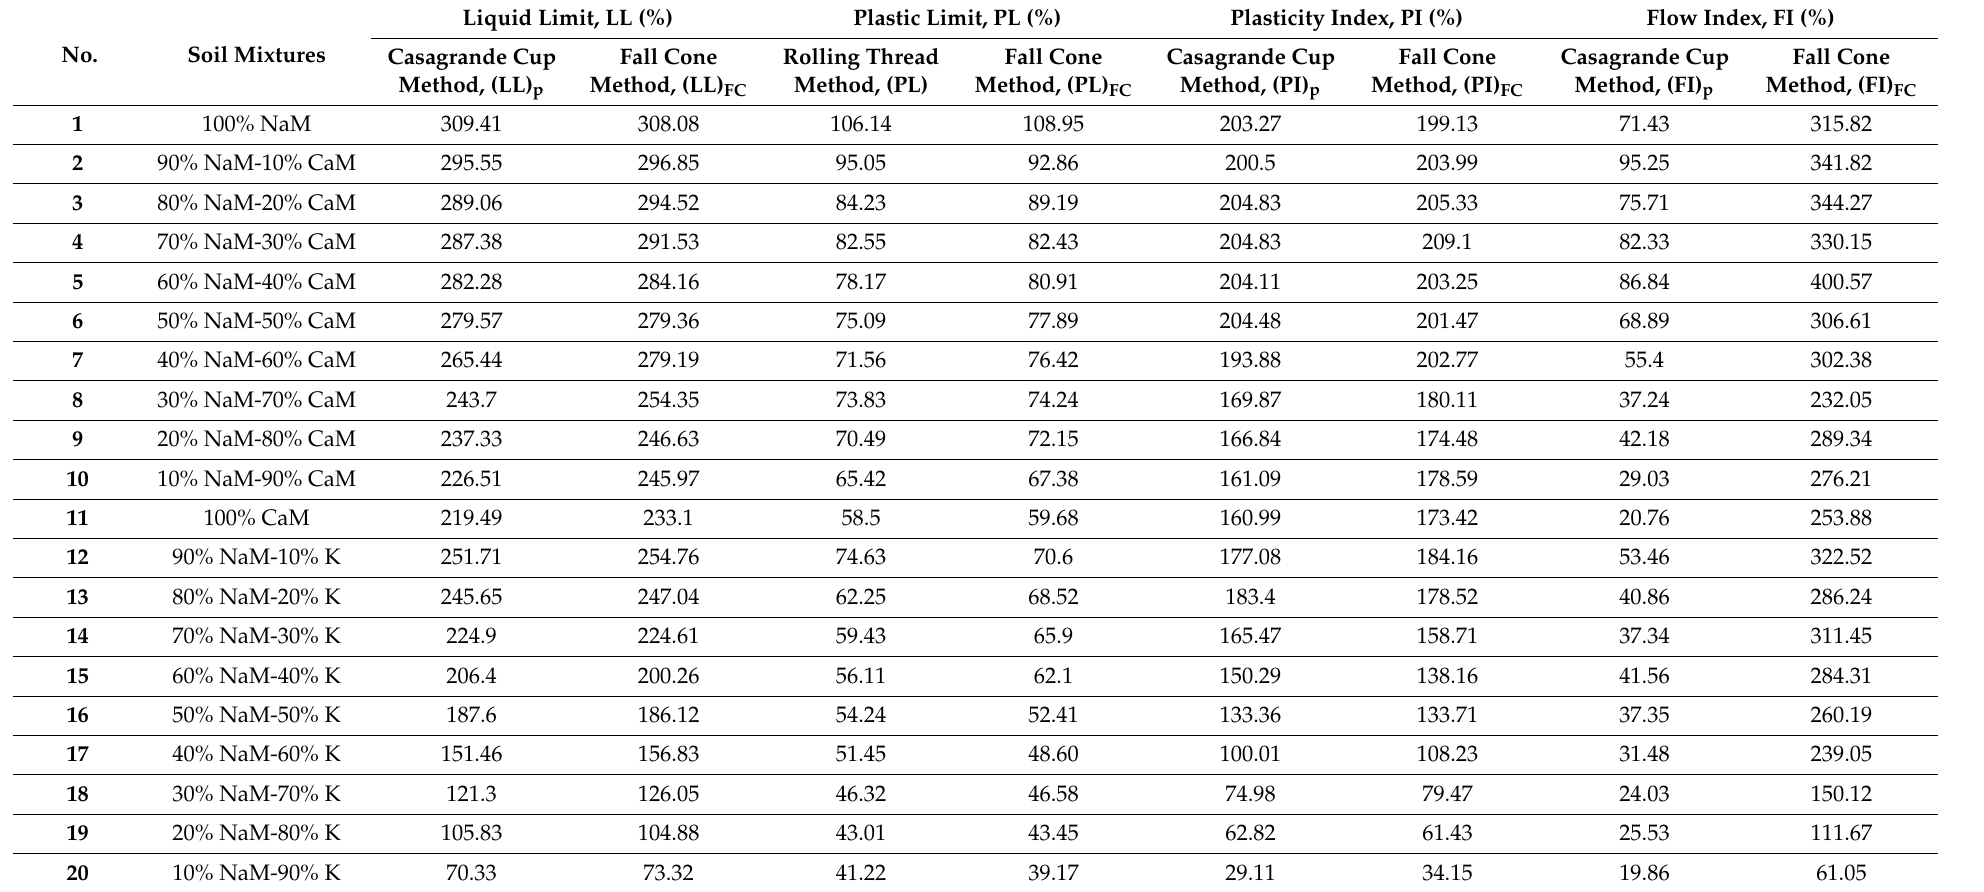
Table 1. Results of tests by both Casagrande cup and Fall cone